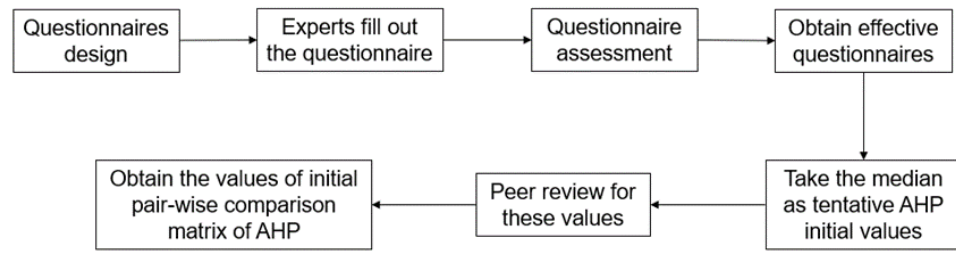
Figure 6. The procedures of initial pair-wise comparison matrix of analytic hierarchy process (AHP) determination.